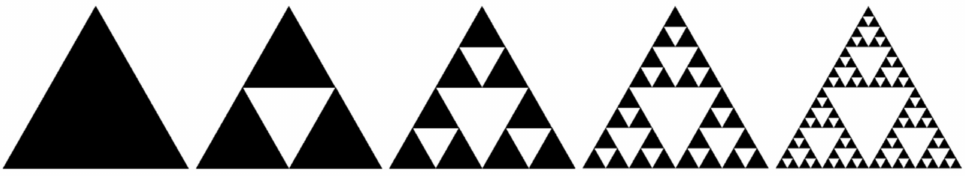
Figure 5. Sierpinski’s